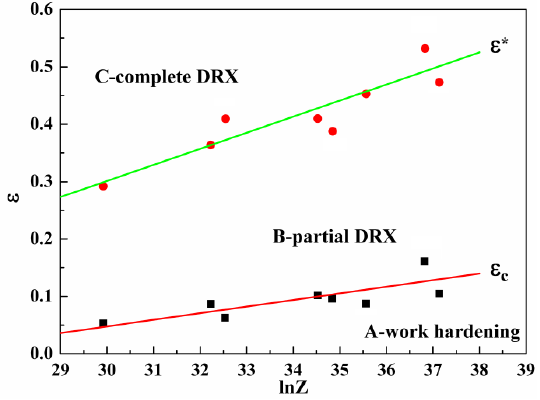
Figure 14. State diagram of DRX for 35CrMo steel under hot temperature deformation.